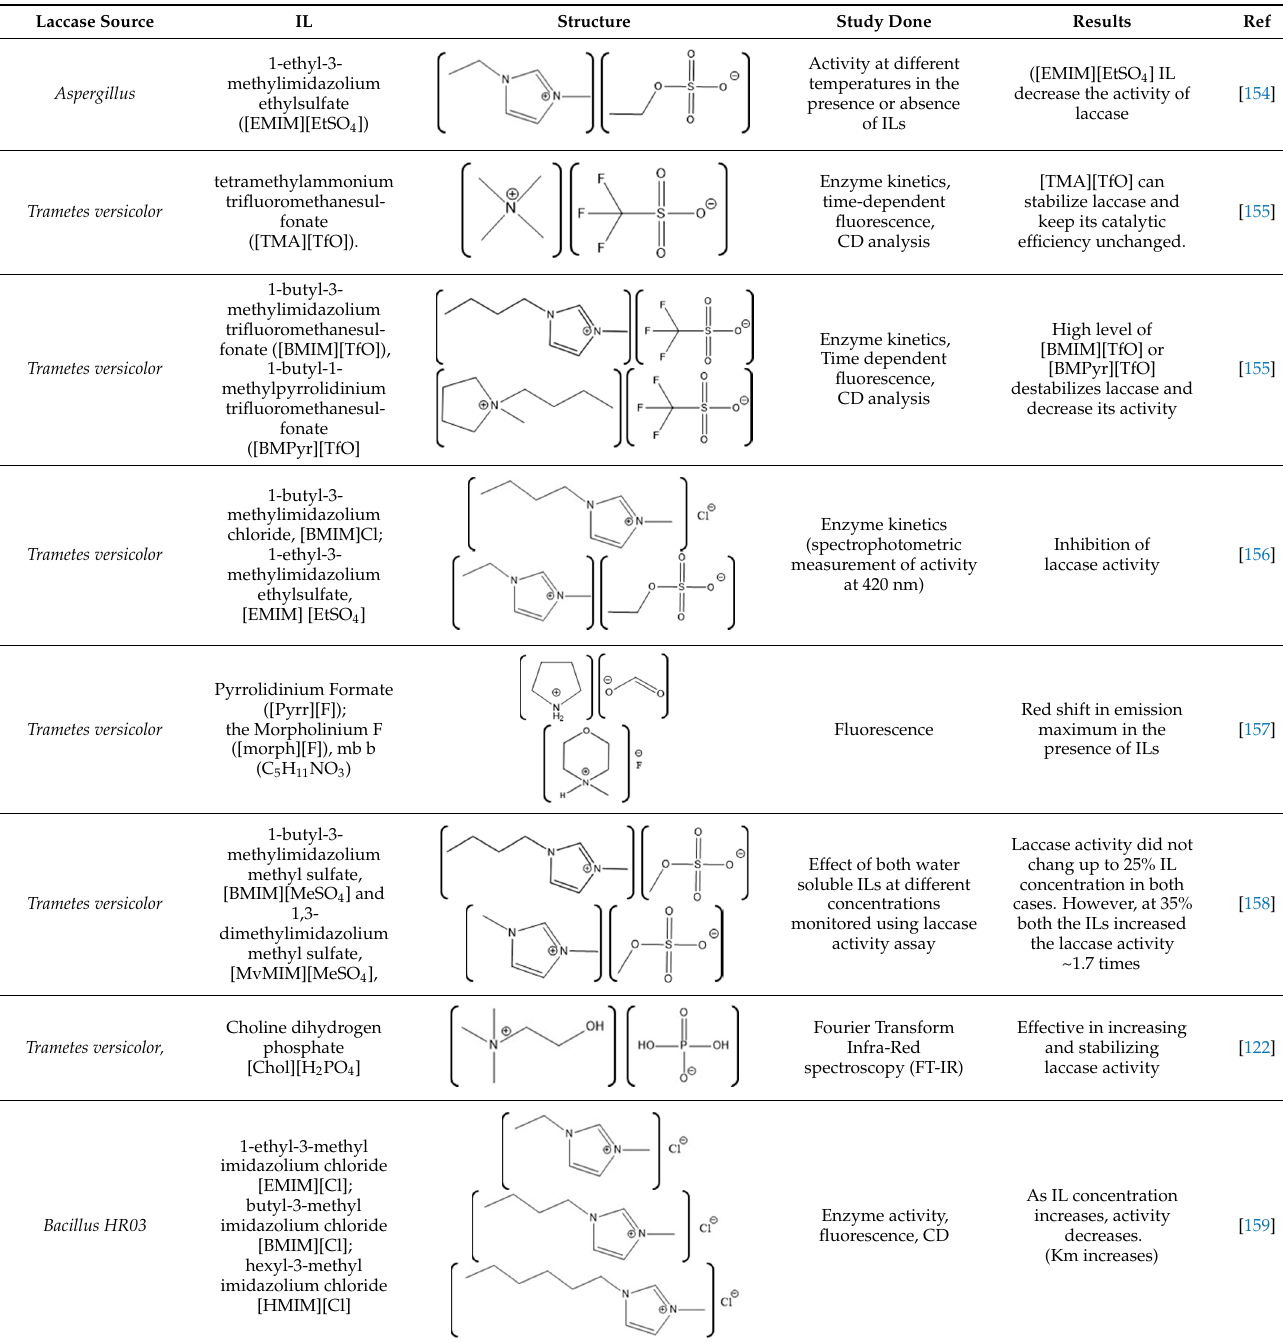
Table 1. Summary of studies done pertaining to monitoring the effects of ionic liquids (ILs) on laccase. Laccase Source